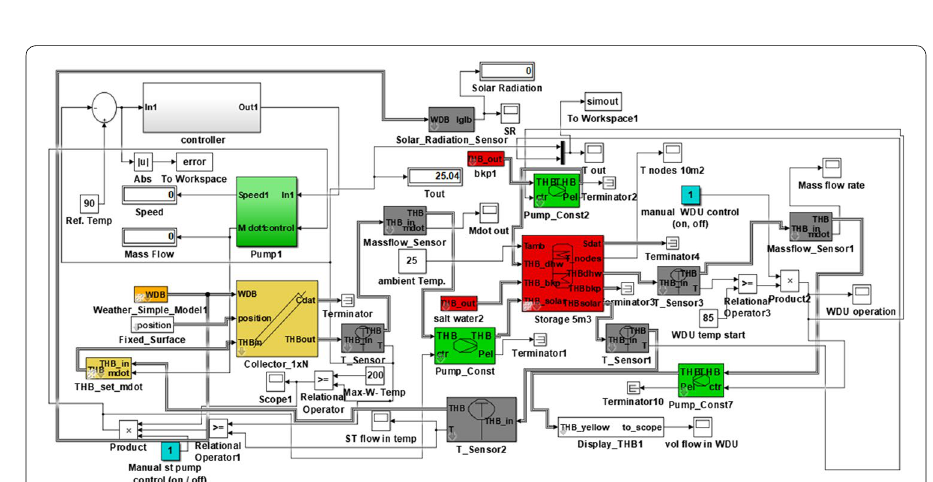
Fig. 5 Model representation of solar collector system in MATLAB